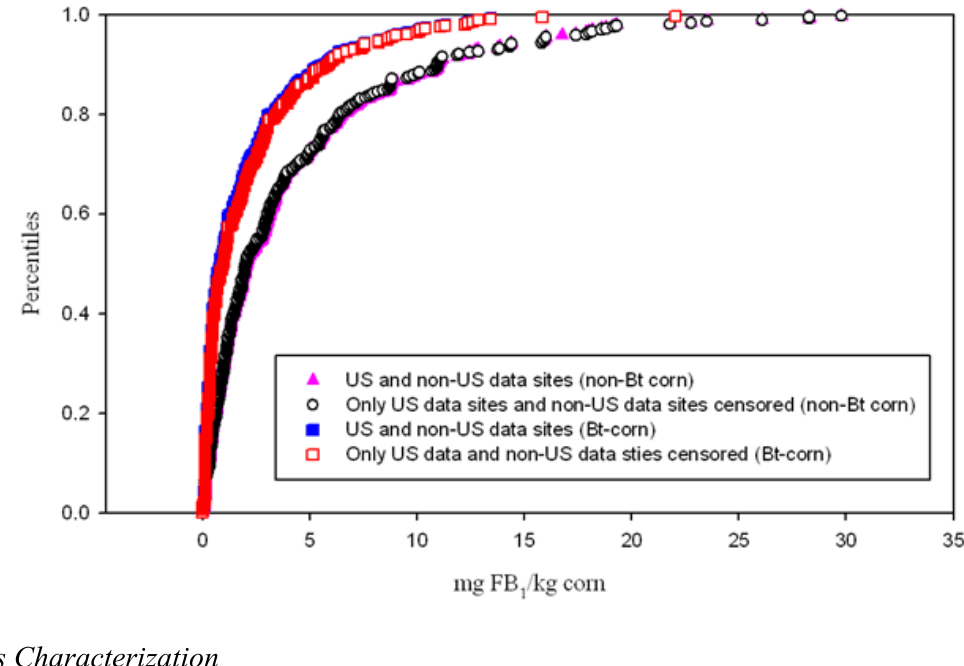
Figure 2. Comparison of US and non-US data versus censoring non-US data showing